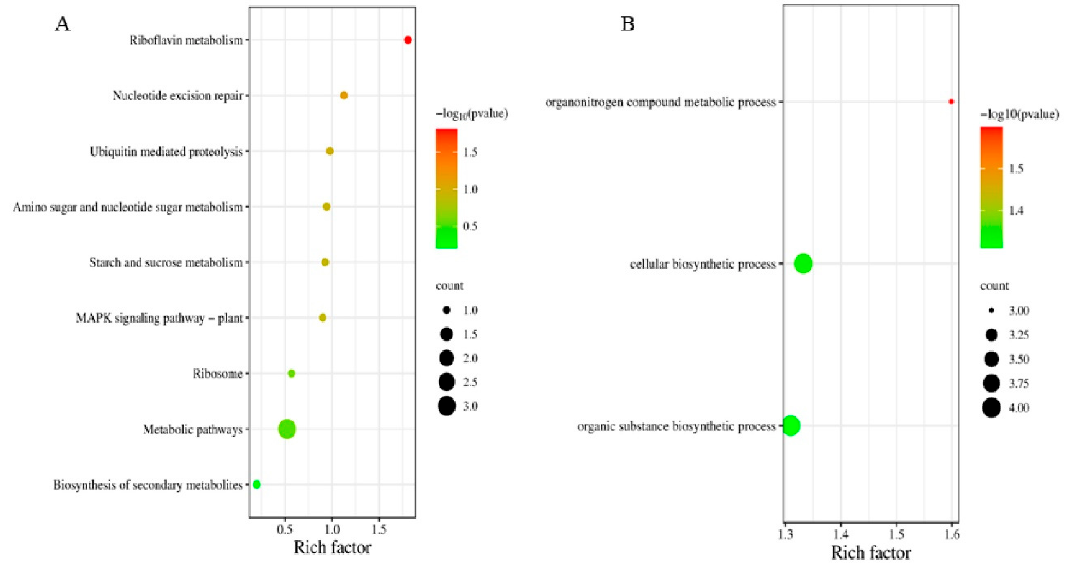
Figure 5. GO terms and KEGG pathways enriched by 29 functionally annotated genes. ( A ) KEGG pathways, ( B ) GO